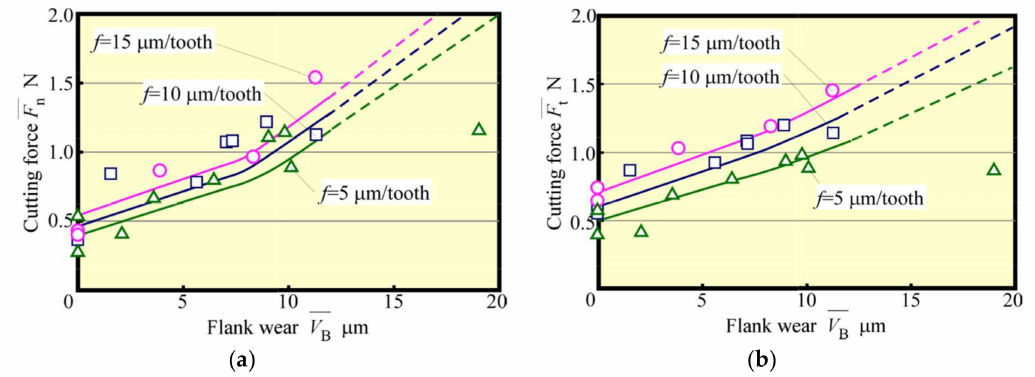
Figure 13. Relationship between flank wear and N c (Up cut, N s = 100,000 min − 1 ).